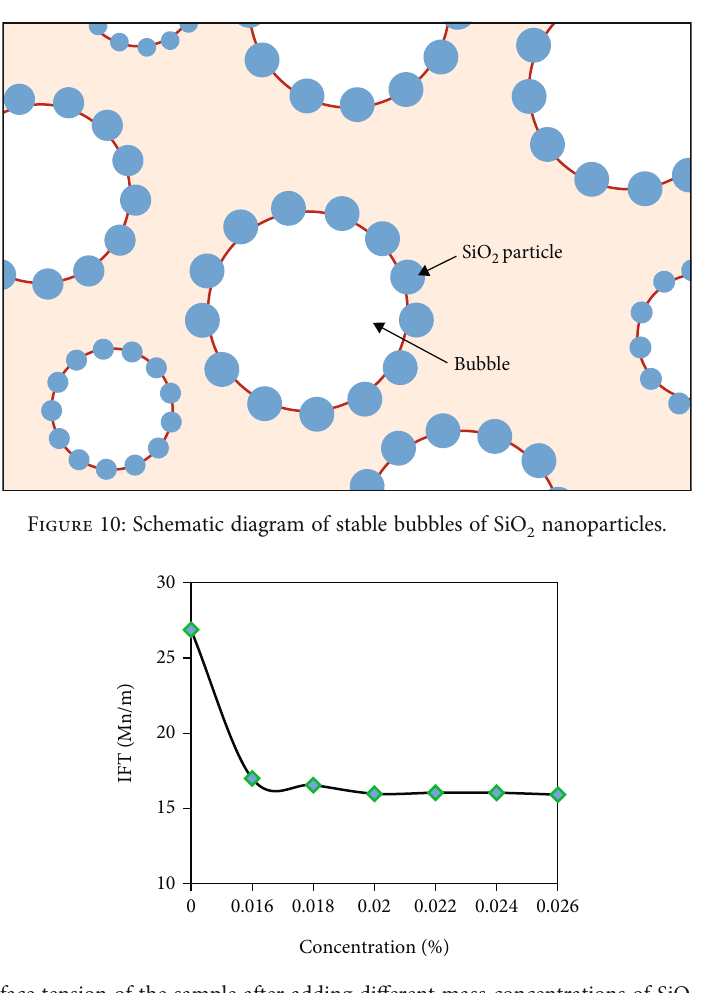
Figure 11: Surface tension of the sample after adding di ff erent mass concentrations of SiO